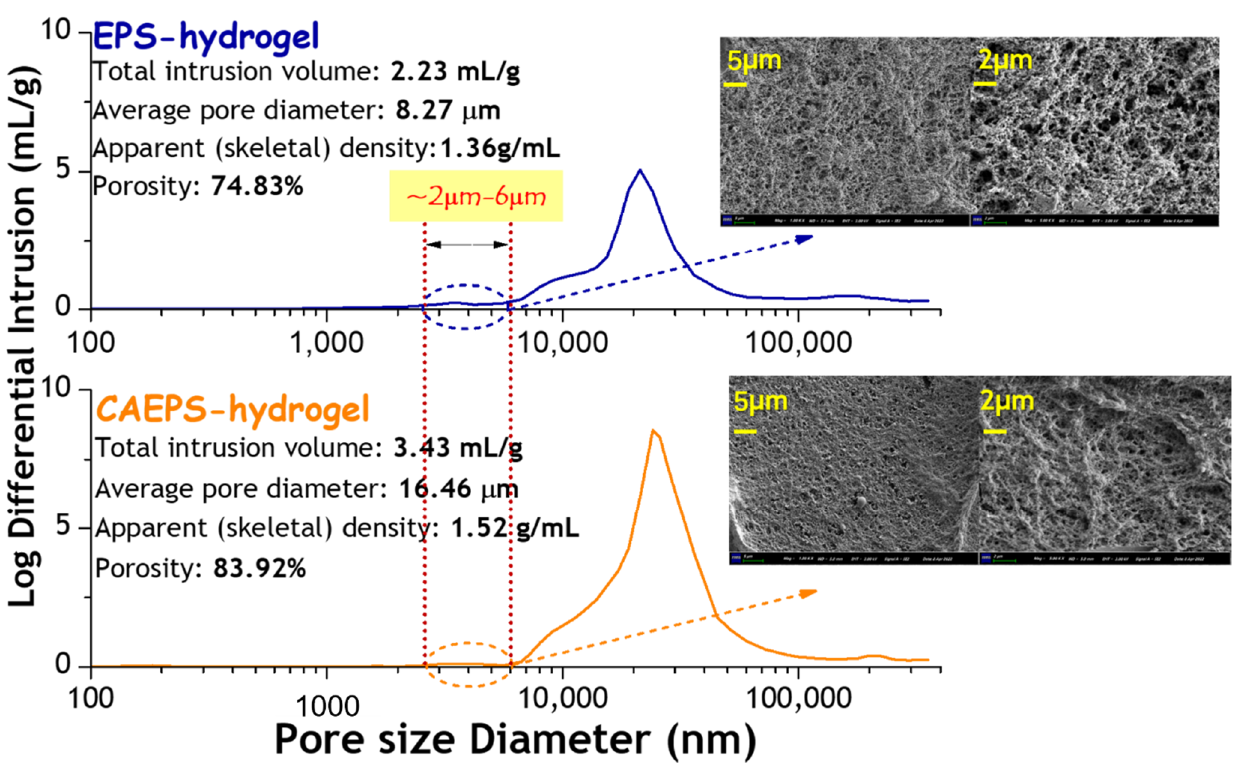
Figure 6. Pore size distribution of EPS- and CAEPS-hydrogels.